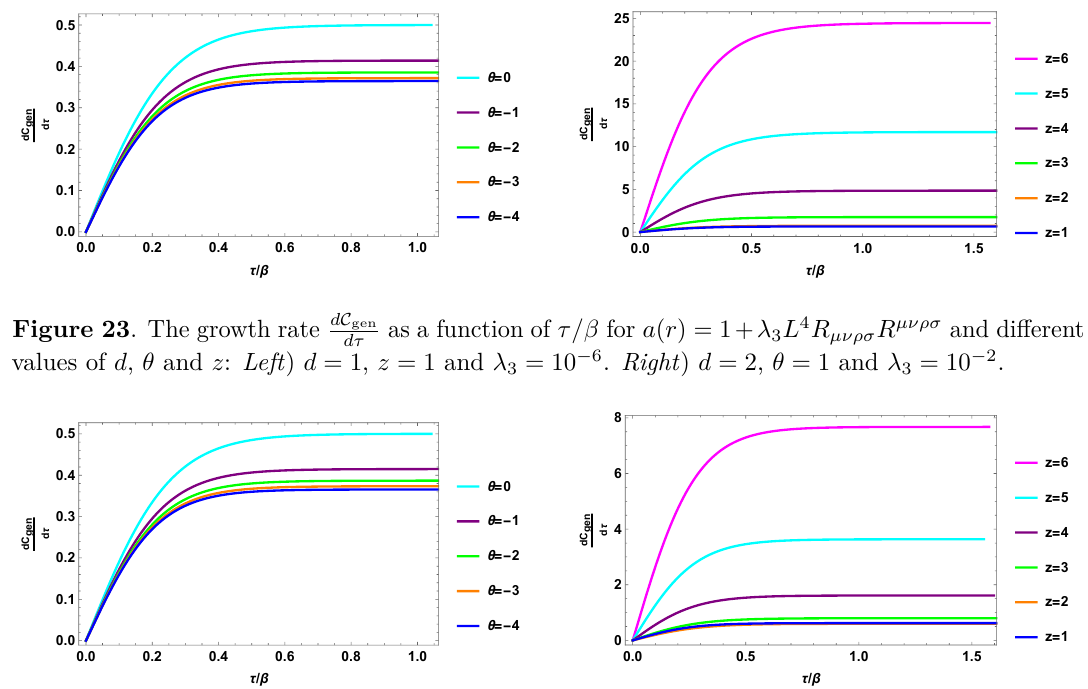
as a function of τ/β for a ( r ) = 1 + λ dτ